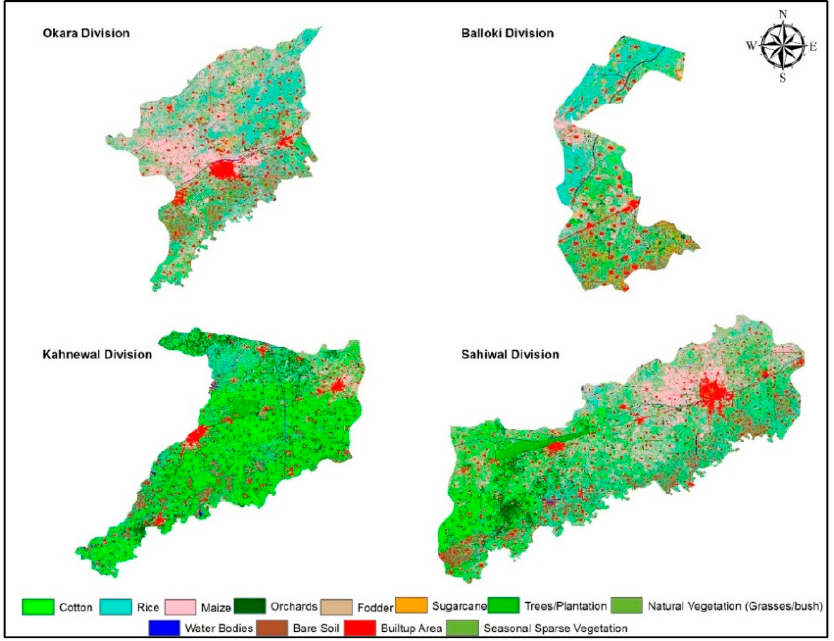
Figure 9. Crop classification-kharif season. Table 2. Crop types statistics in study area.